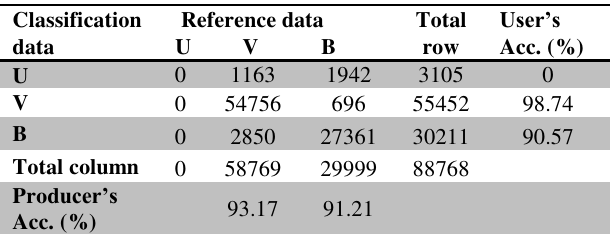
Table 7. Confusion matrix of labelled point based on NDFI G-MIR in Site II